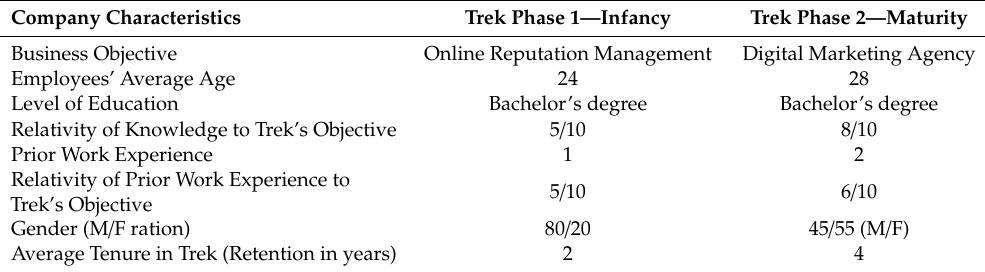
Table 2. Comparison of Company Characteristics between the two Evolutionary Stages of Trek.